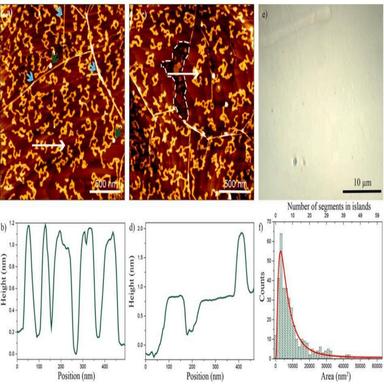
a) AFM image of MoS2 grown on graphene on top of Ir (111) taken after extraction from UHV. b) Height profile along the white arrow in a) which shows thickness of several MoS2 monolayer islands. c) AFM image of a sample area with an etched graphene area outlined by a white dashed line. d) Height profile along the white arrow in c) which shows the thickness of the graphene sheet and one MoS2 island. e) Optical image of sample. f) Distribution of MoS2 islands sizes (histogram) and fit to a log-normal distribut